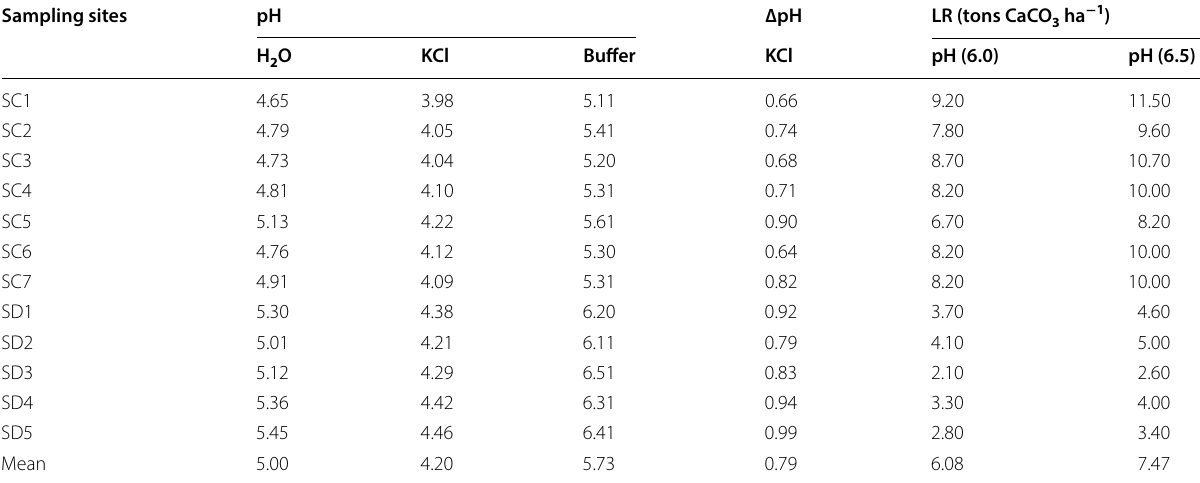
Table 3 Soil pH, buffer pH and lime